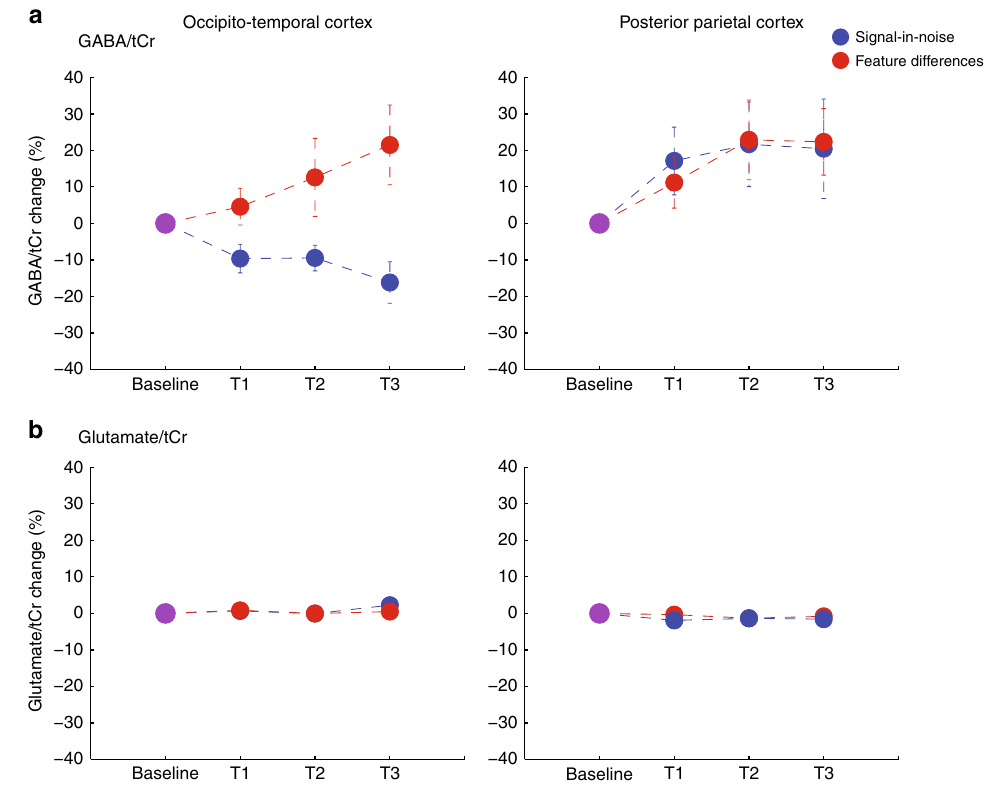
Fig. 3 MR spectroscopy (MRS) measurements of γ -aminobutyric acid (GABA) and glutamate during training. a MRS-measured GABA over time is shown from two voxels (occipito-temporal, posterior parietal cortex) per task (signal-in-noise, feature differences). For each MRS voxel, we calculated % GABA change: we normalized GABA/tCr per training block (T1, T2, T3) to GABA/tCr recorded during the baseline block; that is, we computed GABA/tCr change subtracting GABA/tCr measurements in each of the three training blocks from the baseline block and then divided by GABA/tCr in the baseline block. We observed maximum (across blocks) 20% GABA change (mean across participants). This is consistent with previous studies measuring GABA at 3T that have reported changes in GABA between 10 and 15% within a single session (duration of 20 – 30 min) of stimulation 75 or training 13 . Ultra-high fi eld imaging (i.e., 7T) has been shown to have increased sensitivity for MR spectroscopy measurements 19,20 and may result in enhanced and more accurate detection of learning-dependent changes in GABA. b MRS-measured glutamate over time is shown from two voxels (occipito-temporal, posterior parietal cortex) per task (signal-in-noise, feature differences). For each MRS voxel, we calculated % glutamate change: we normalized glutamate/tCr per training block (T1, T2, T3) to glutamate/tCr recorded during the baseline block; that is, we computed glutamate/tCr change subtracting glutamate/tCr measurements in each of the three training blocks from the baseline block and then divided by glutamate/tCr in the baseline block. Error bars indicate standard error of the mean across participants. Error bars are not visible for small changes in metabolite